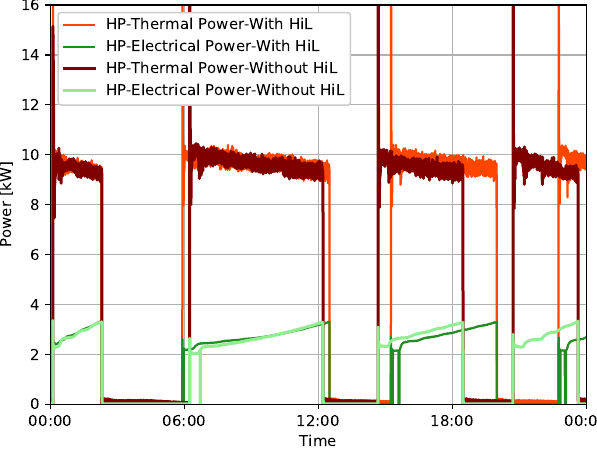
Figure 7. Thermal and electrical power of the heat pump with and without